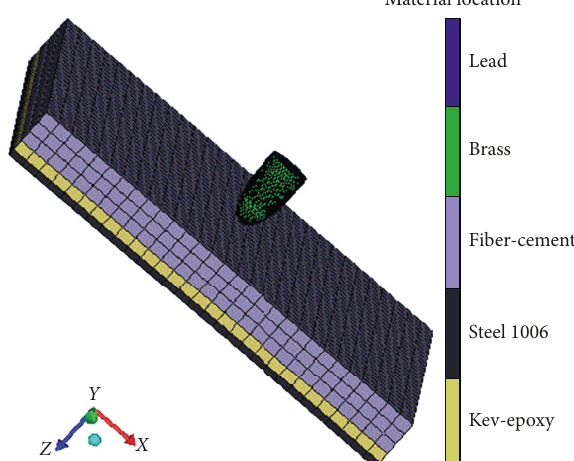
Figure 4: Sample 2 and the firing direction as modeled on Ansys AUTODYN.